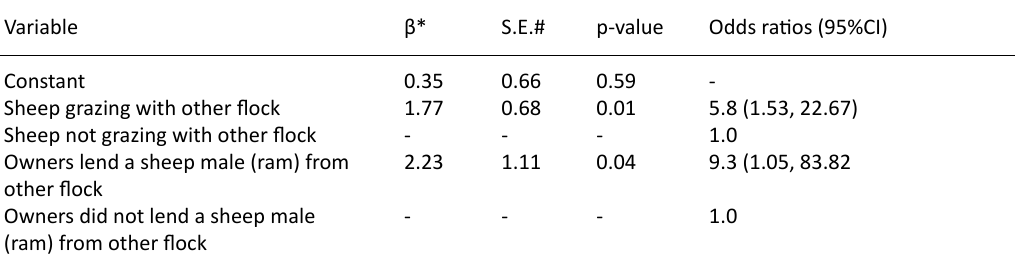
Table 6. Logistic regression results of association of significant factors (sheep management & practices) with the seroprevalence of brucellosis